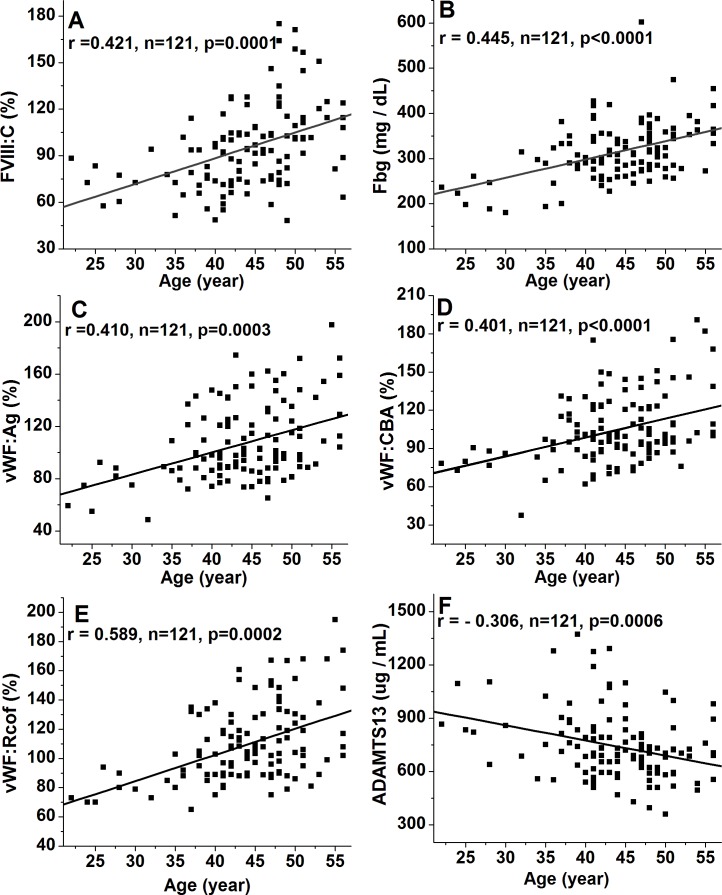
Relationship between age and plasma levels of FVIII:C, Fbg, VWF(Ag, CBA, and Rcof), and ADAMTS13 antigen.The diagonal lines indicate linear regression, and Poisson analysis was used. (A) Relationship between age and FVIII:C; (B) Relationship between age and Fbg; (C) Relationship between age and VWF:Ag; (D) Relationship between age and VWF:CBA; (E) Relationship between age and VWF:Rcof; (F) Relationship between age and ADAMTS13 antigen. Strong positive linear correlations are present for FVIII:C, Fbg, VWF:Ag, VWF:CBA, and VWF:Rcof, whereas a negative association is present for ADAMTS13 antigen.